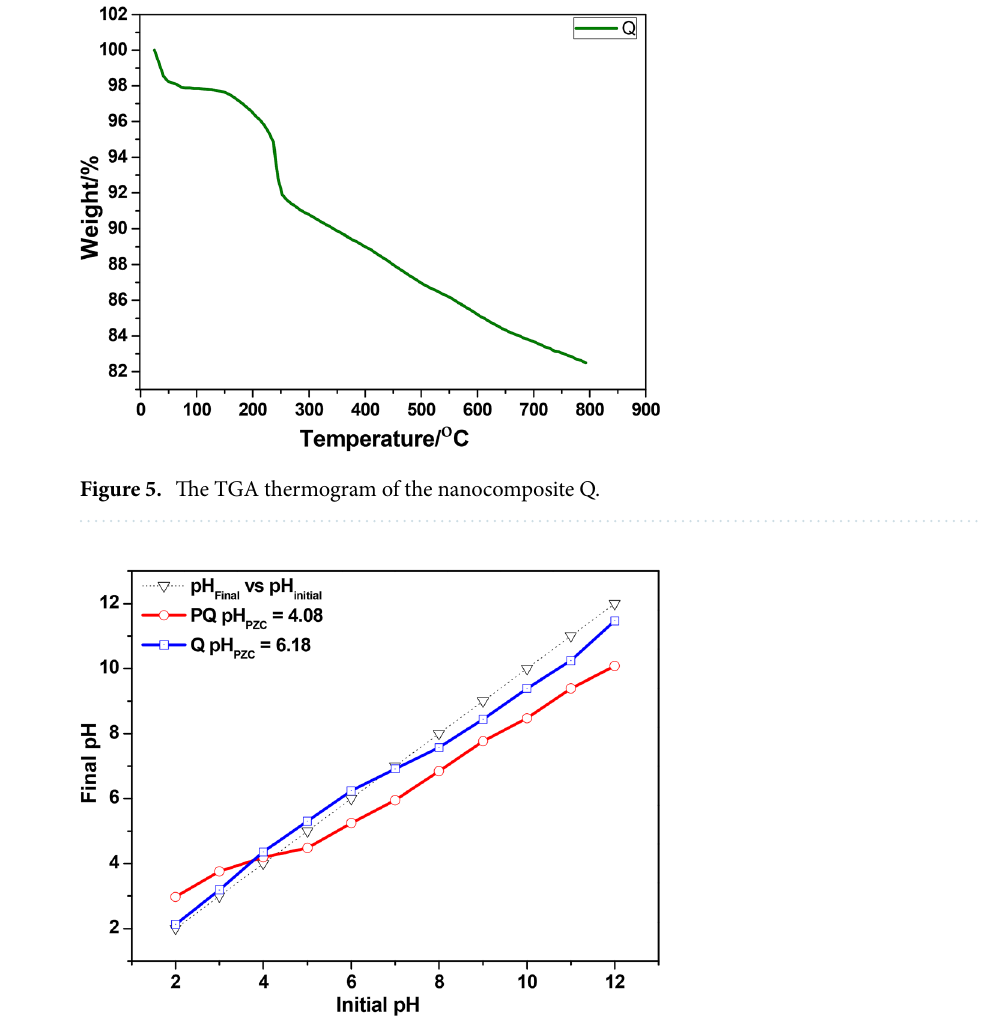
Figure 6. pH PZC plots of PQ and Q.